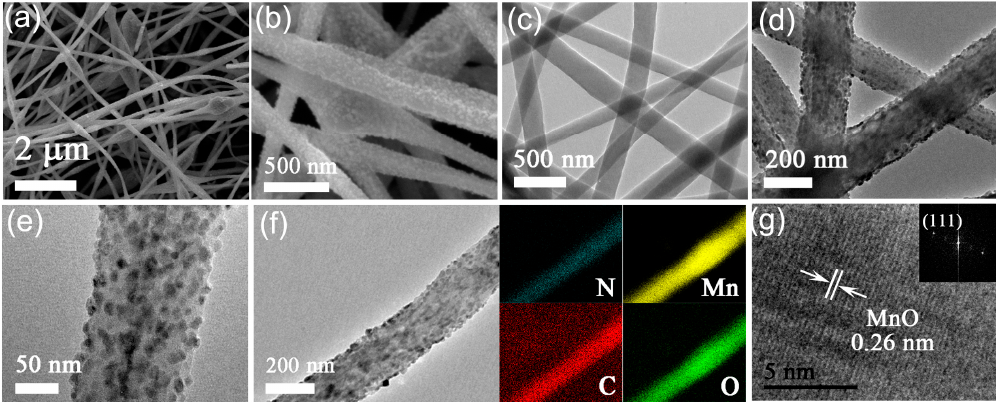
Figure 4. ( a , b ) Scanning electron microscopy (SEM) and ( d , e ) transmission electron microscopy (TEM) images of MnO@CFs. ( c ) TEM image of CFs. ( f ) Element mapping of C, N, O, and Mn for an individual MnO@CFs. ( g ) high-resolution TEM (HRTEM) image of a random MnO nanoparticle on CFs.